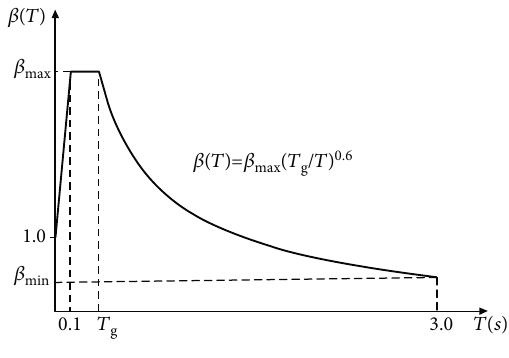
Figure 2: Standard design reaction